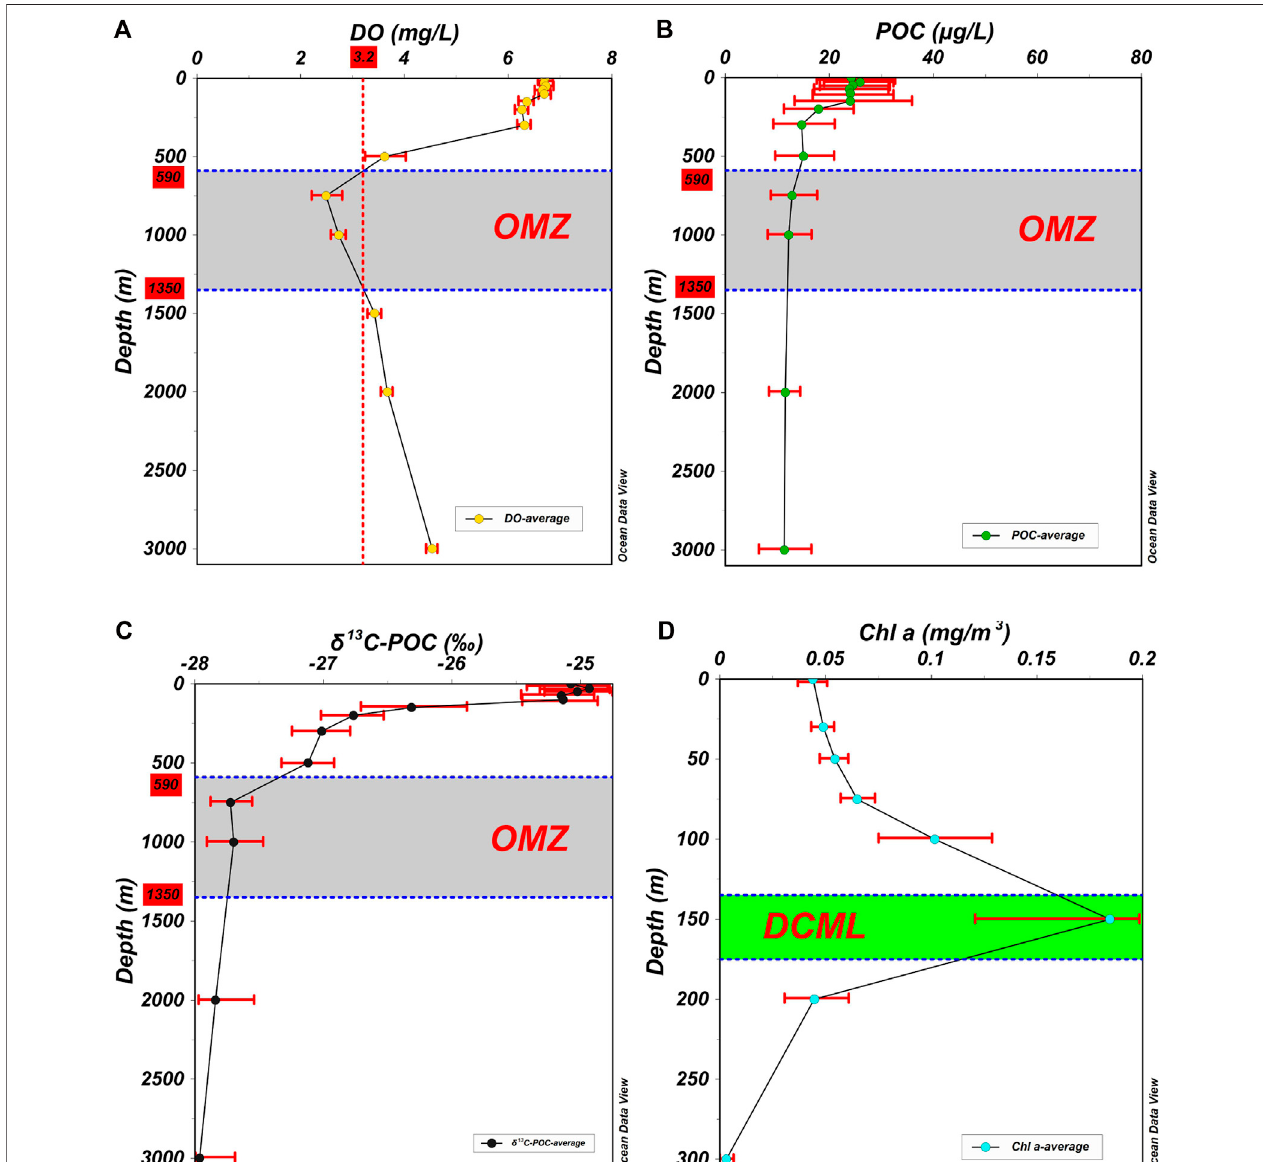
FIGURE 3 | Vertical distribution of average DO, POC, δ 13 C-POC, and Chl a in the Kocebu seamount area. (A) The average DO of all stations. There was an oxycline in the water column of 300 – 750 m. The grey area represented OMZ, which was located in the water column of 590 – 1,350 m based on the DO threshold of 3.20 mg/L. (B) The average POC of all stations. In the OMZ, the decomposition rate of POC was lower than that in the water column of 150 – 300 m. (C) The average δ 13 C-POC of all stations. The δ 13 C-POC showed similar characteristics as POC, which was heavier in the water column of 0 – 100 m, then decreased rapidly in the water column of 100 – 500 m. In the OMZ, δ 13 C-POCwas signi fi cantly lower than that in thewater column of100 – 500 m. (D) The average Chl a of all stations. The green area represented DCML, which was located in the water column of 135 – 175 m. The good seawater mixing and the existence of DCML caused a high POC concentration in the water column of 0 – 100 m. In these fi gures, the red bars represented the standard deviation of different parameters.